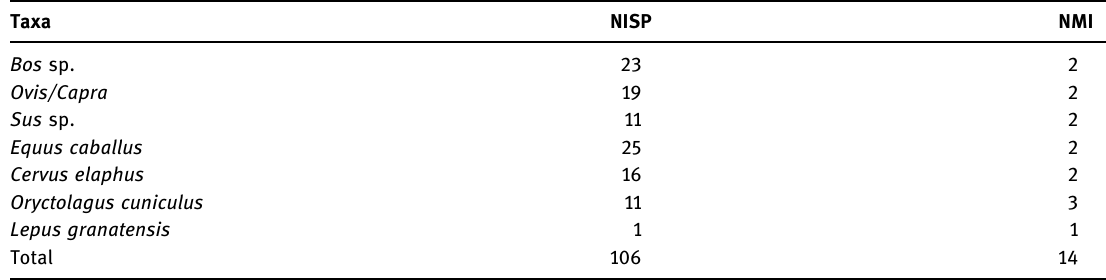
Table 1: Taxonomic representation of animal remains recovered at the Neolithic levels of La Atalaya Taxa NISP NMI Bos sp. 23 2 Ovis/Capra 19 2 Sus